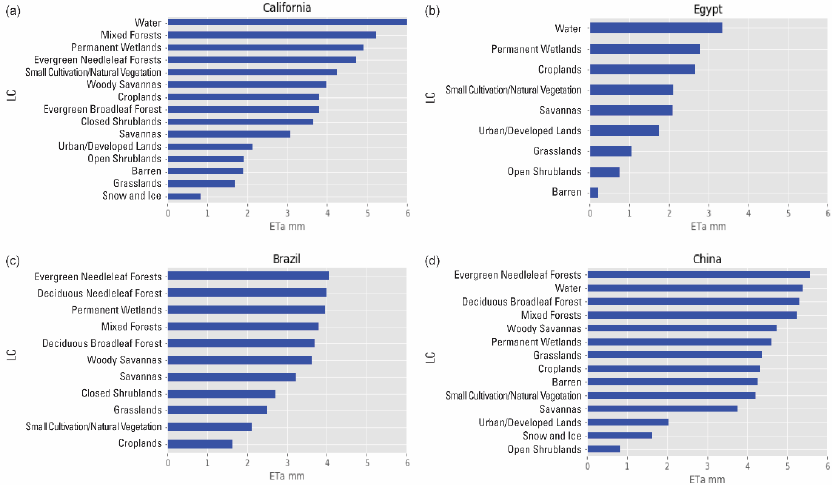
Figure 11. Sample on-demand SSEBop ETa averages by landcover type showing relative distribution of ETa in different parts of the world for different seasons. Subfigures (a-d) correspond of ETa in different parts of the world for different seasons. Subfigures ( a – d ) correspond to the Landsat to the Landsat SSEBop ETa in Figure 10 (a-d). SSEBop ETa in Figure